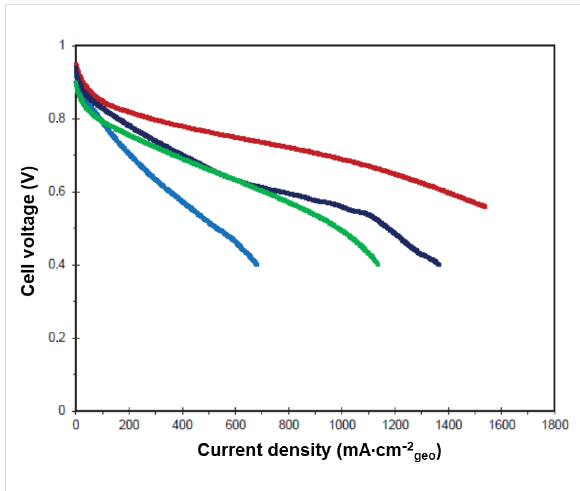
Figure 10: Polarization of Pt 3 Co/CB (red); Pt 3 Co/N-CNT (dark blue); Pt 3 Co/N-CNT HT (light blue) and Pt 3 Ni/N-CNT HT (green) recorded under air, P inlet = 2.5 bar, T = 80 °C, St H2 = 1.2; St Air = 3.5, RH anode = 50%; RH cathode = 30%.